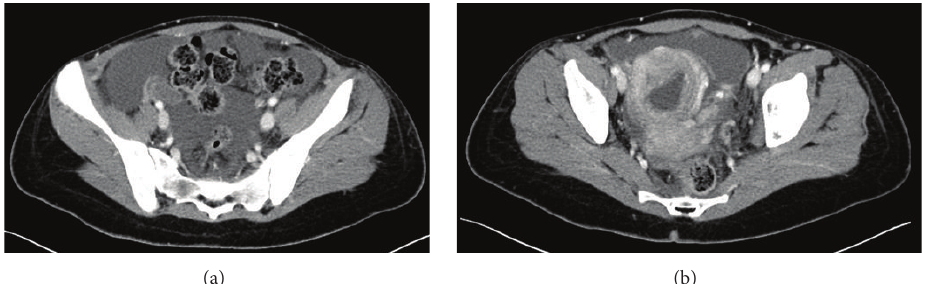
Figure 3: CT pelvis showing haematoma extending to pelvis. Gravid uterus is